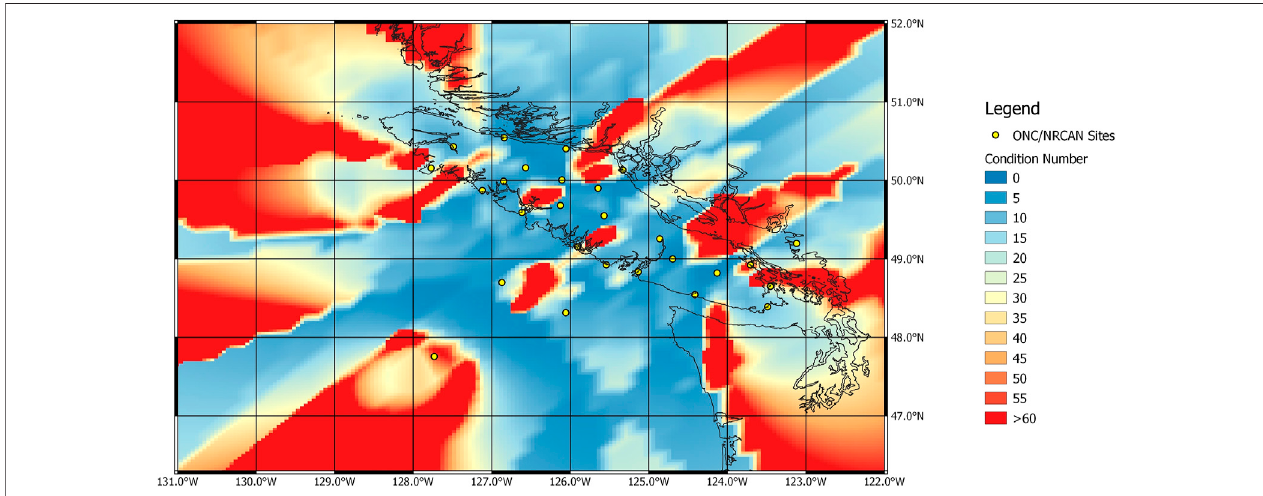
FIGURE5 | Results from the LLS algorithm for the fi rst four stations thatdetected an event located anywhere in thegeographic region. Condition numbers greater than 30 are connected predominately to regions where the relative base-line of the respective four station array is short. Yellow circles mark the location of the seismic stations that were included in the modelling